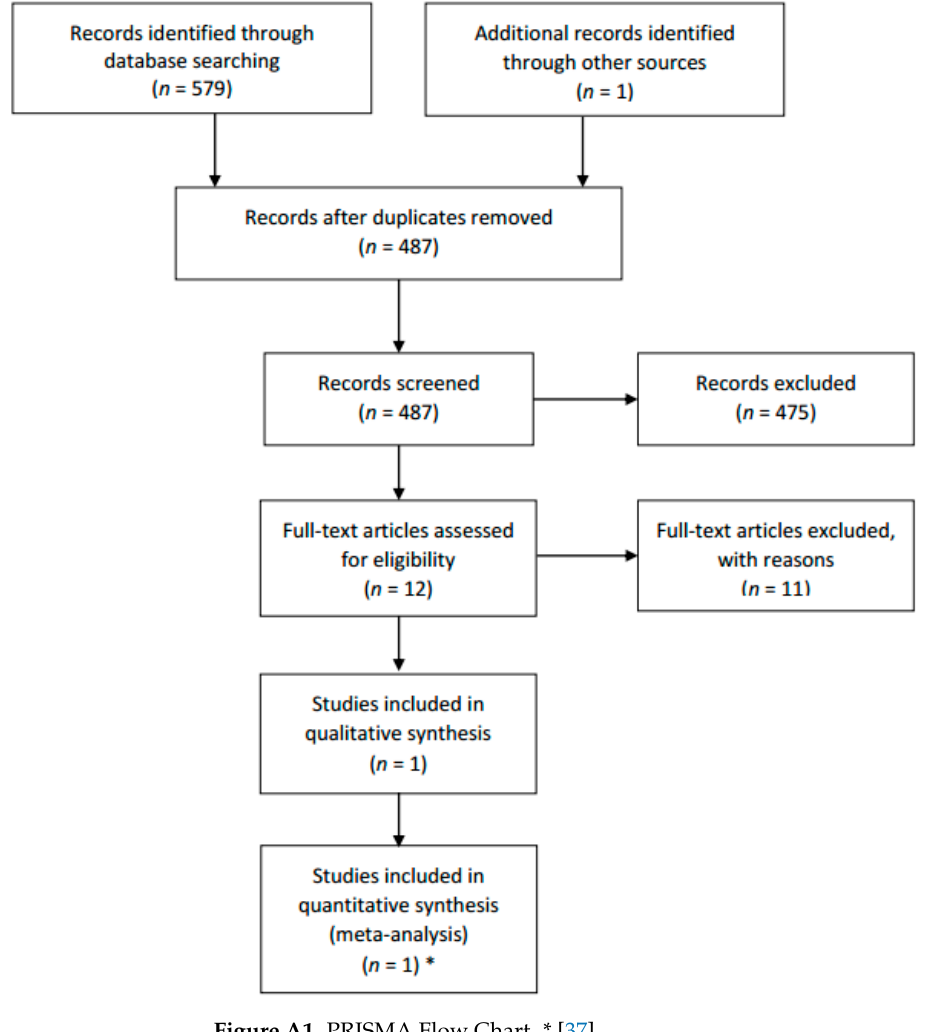
Figure A1. PRISMA Flow Chart. * [37].